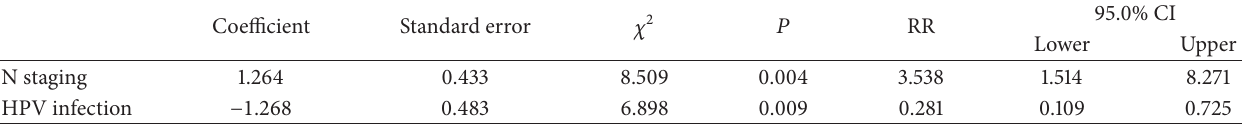
Table 5: Multivariate analysis of prognosis in 63 cases of tongue squamous cell